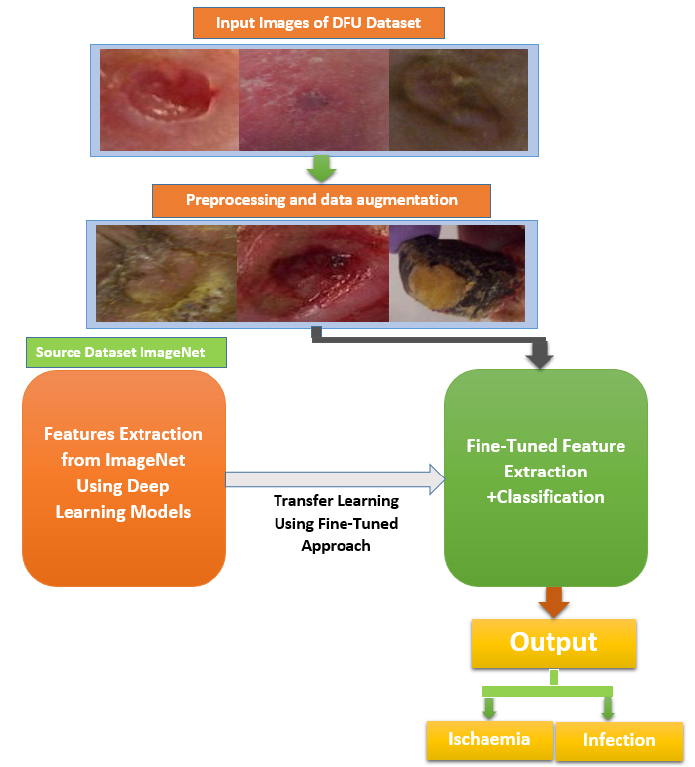
Figure 1. Proposed framework of transfer learning using fine-tuning approach for classification of ischemia and infection classes of DFU .